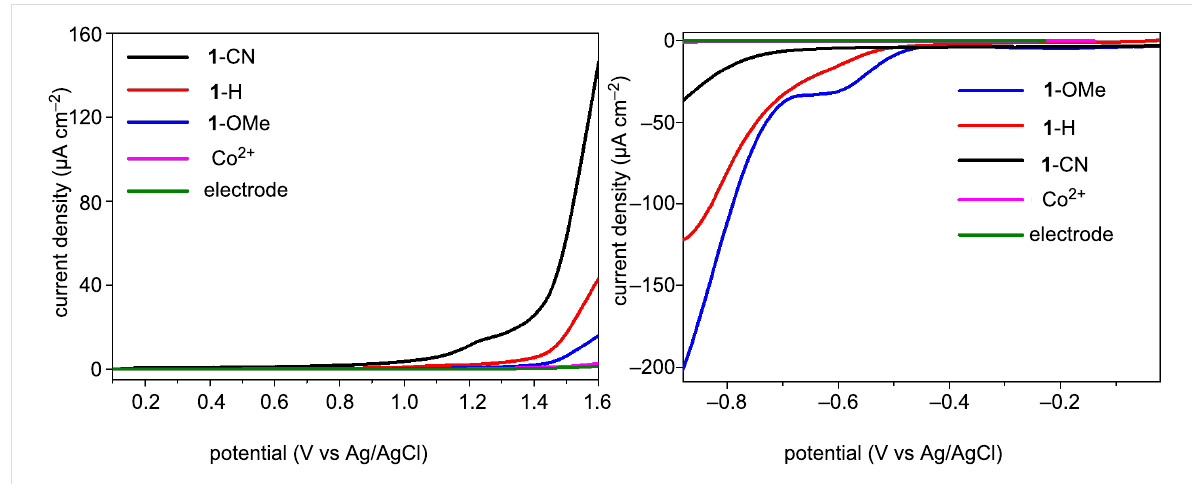
Figure 4: Linear sweep voltammetry of 1 -R (0.3 mM) or Co(NO 3 ) 2 ·6H 2 O (1.2 mM); (a) at a 100 mV/s scan rate in 0.2 M Na 2 SO 4 , (b) at a 50 mV/s scan rate in MeCN (0.1 M TBAPF 6 ) under CO 2 -saturated conditions. The working electrode used was 3 mm diameter glassy carbon electrode, the counter electrode was a platinum foil and the reference electrode was a Ag/AgCl.